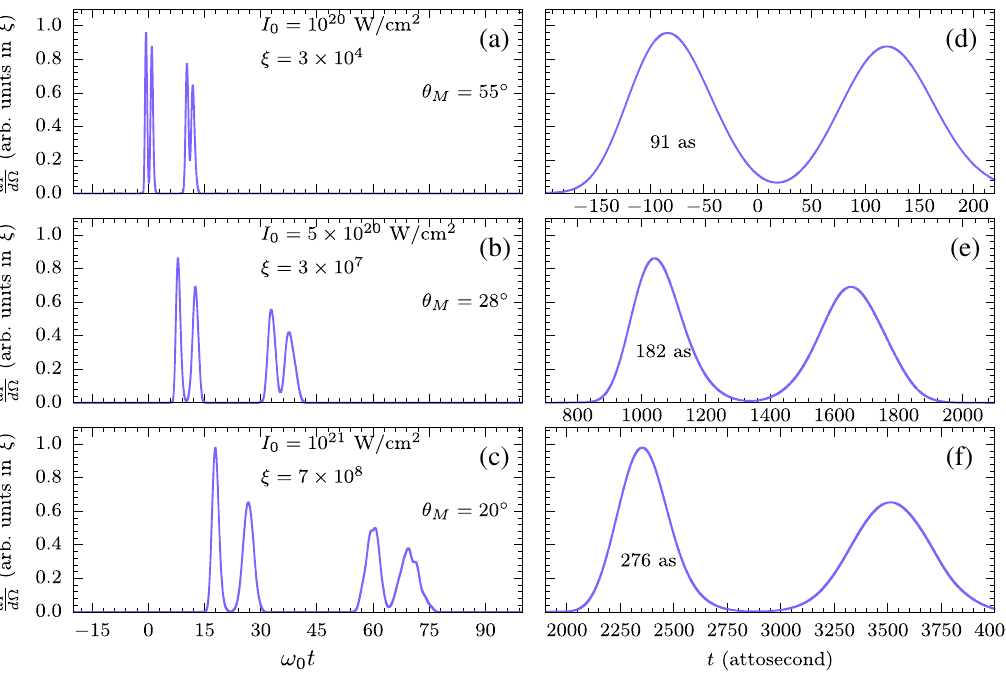
FIG. 6. The attosecond burst of the radiated energy has been presented for the intensities (a) 10 20 W = cm 2 , (b) 5 × 10 20 W = cm 2 , and (c) 10 21 W = cm 2 along the direction of respective θ m . The zoomed signal has been also shown in panels